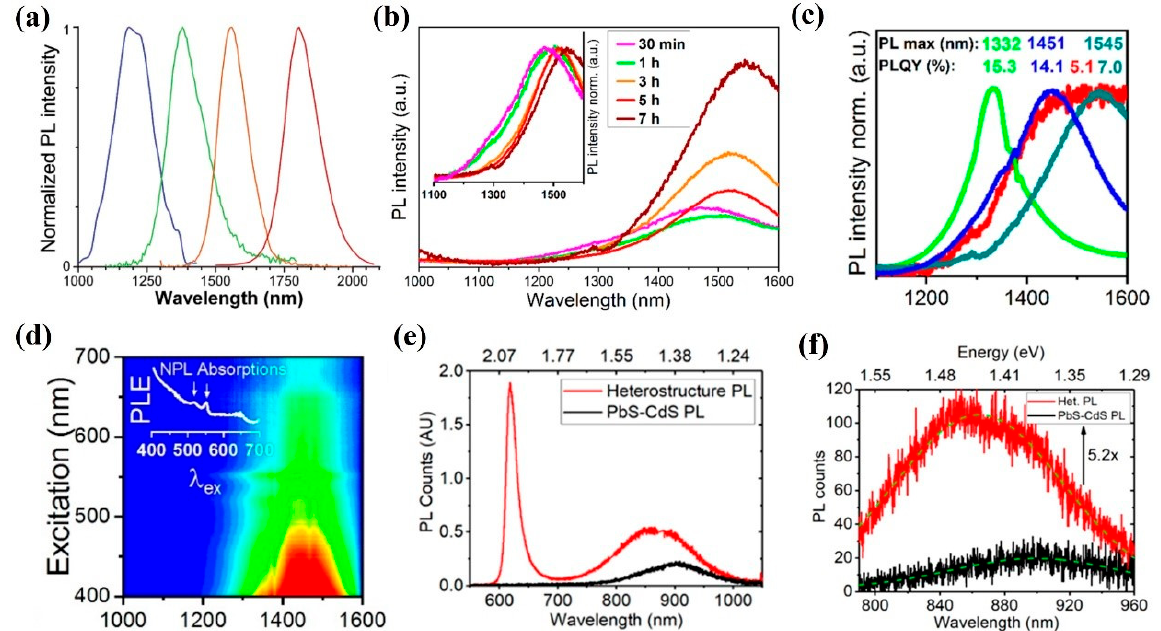
Figure 4. Light emission based on other 2D materials. ( a ) The normalized PL spectra of PbSe with different sizes. ( b , c ) The PL spectra of PbSe nanoplatelets with different reaction times and different PbSe populations, respectively. Inset of (b): normalized PL spectra. ( d ) The PL map of PbSe/CdSe heterostructure. ( e ) The PL spectra of WS 2 − PbS − CdS heterostructure and PbS − CdS. ( f ) The PL spectra of bare substrate and PbS − CdS QD. ( a ) Reprinted from [143], with permission from American Chemical Society, 2003; ( b , c ) Reprinted from [144], with permission from American Chemical Society, 2019; ( d ) Reprinted from [112], with permission from American Chemical Society, 2016; ( e , f ) Reprinted from [145], with permission from American Chemical Society, 2021.